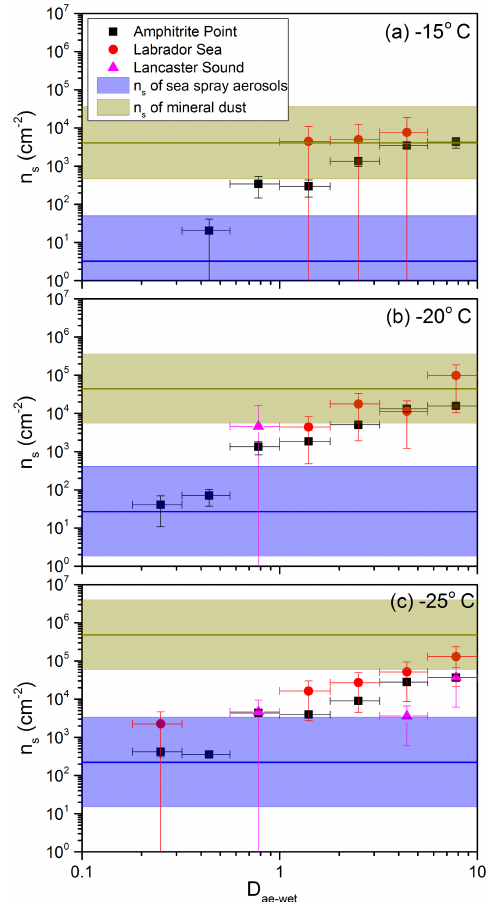
Figure 7. Comparison of measured n s values with previously re- ported n s values of sea spray aerosols and mineral dust at − 15, − 20, and − 25 ◦ C, respectively. The n s values of sea spray aerosols were taken from DeMott et al. (2016), and the n s values of mineral dust were taken from Niemand et al. (2012). The horizontal lines represent the calculated n s values from linear regression, and the coloured bands represent the 95% prediction bands (see Figs. S5– S6). Blue represents sea spray aerosols, and light green represents mineral